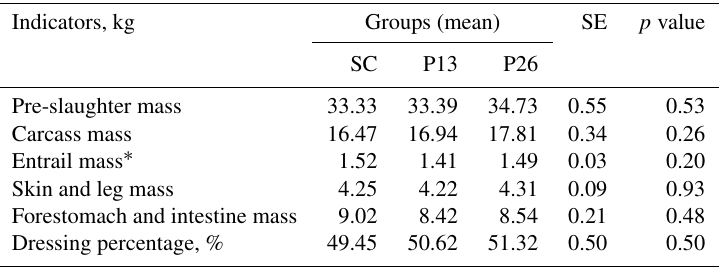
Table 5. Slaughtering characteristics of lamb carcasses.